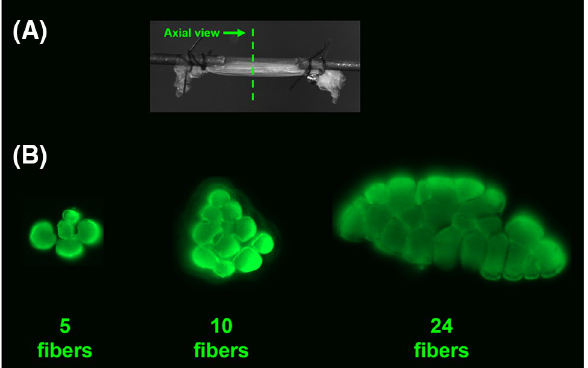
Figure 1. Muscle fiber bundle specimen for mechanical testing; ( A ) The specimens were mounted onto two collinear pins and secured to them via suture loops. ( B ) Axial view of three tested muscle fiber bundles. Out